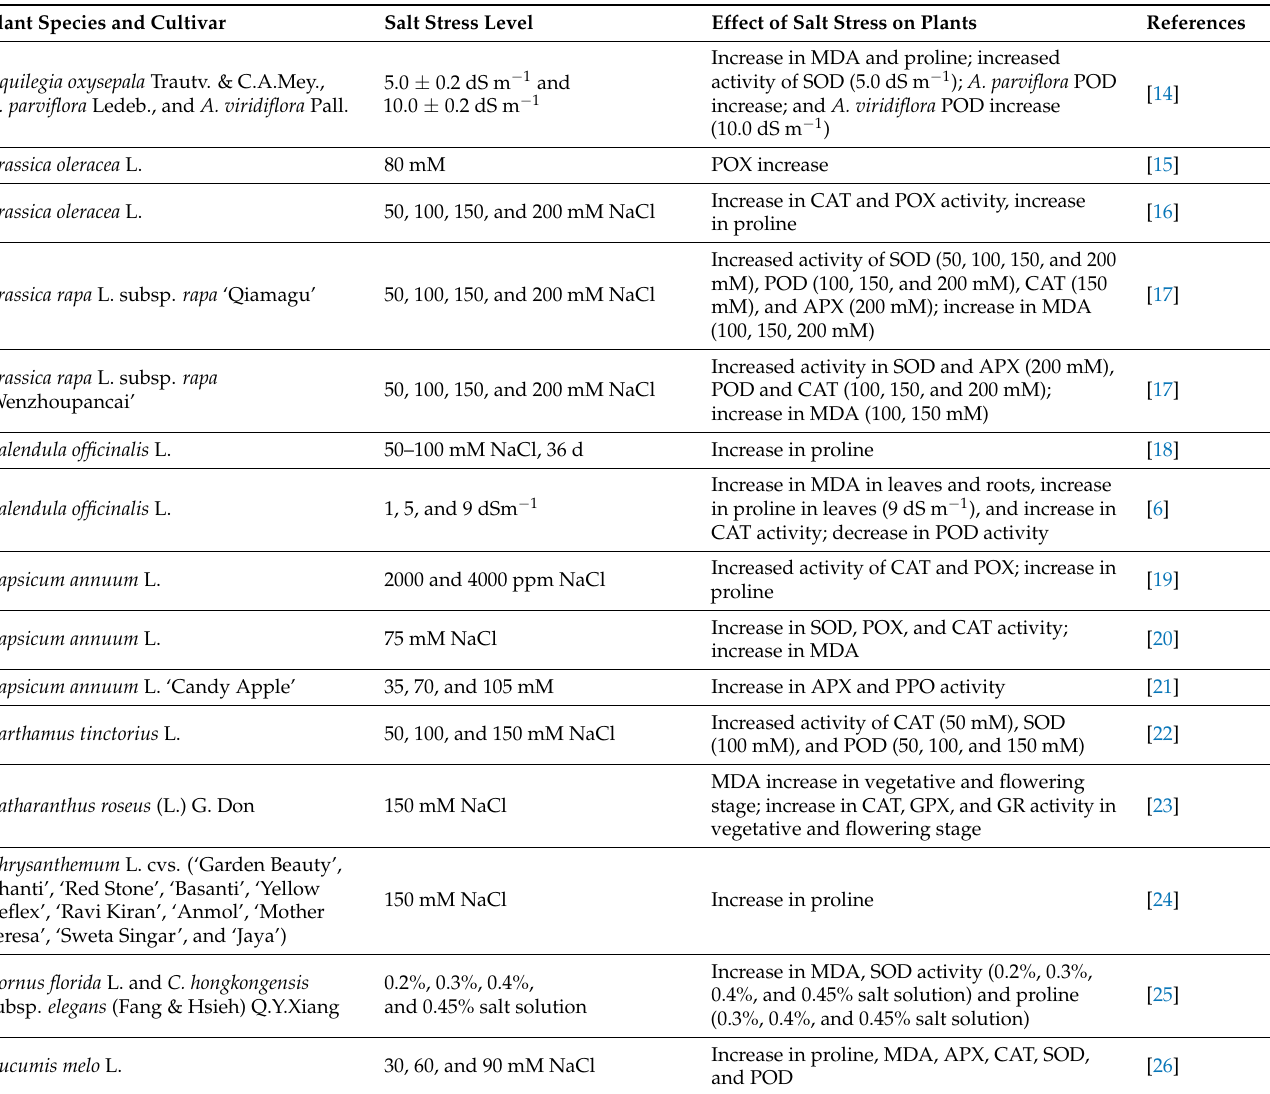
Table 1. Main molecular effects of salt stress in different vegetable and ornamental